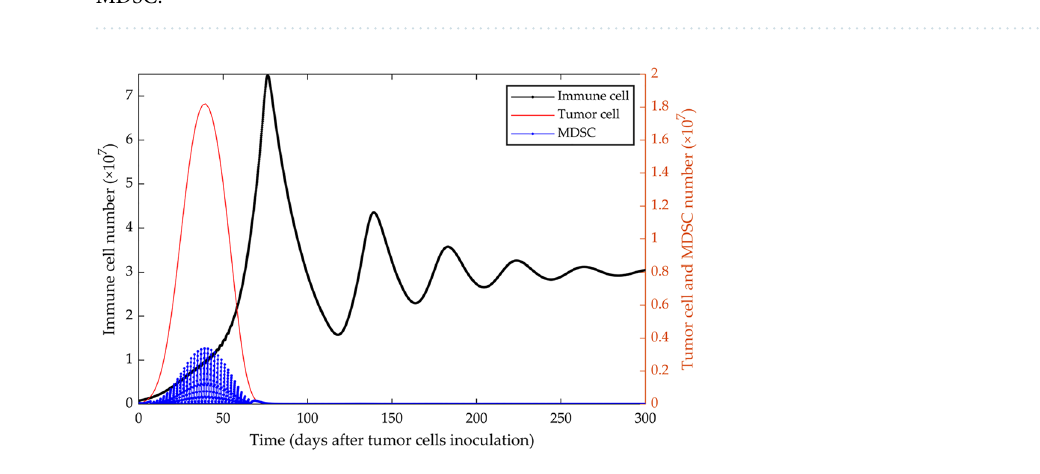
Figure 2. Simulation of MDSC depletion from tumor-bearing mice. By simulating the depletion of MDSCs every 48 h and for 2 months starting from day 7 after the injection of 5 × 10 4 4T1 tumor cells in immunocompetent mice, the tumor growth is halted. The left y-axis represents the number of immune cells, and the right y-axis shows the number of MDSCs and tumor